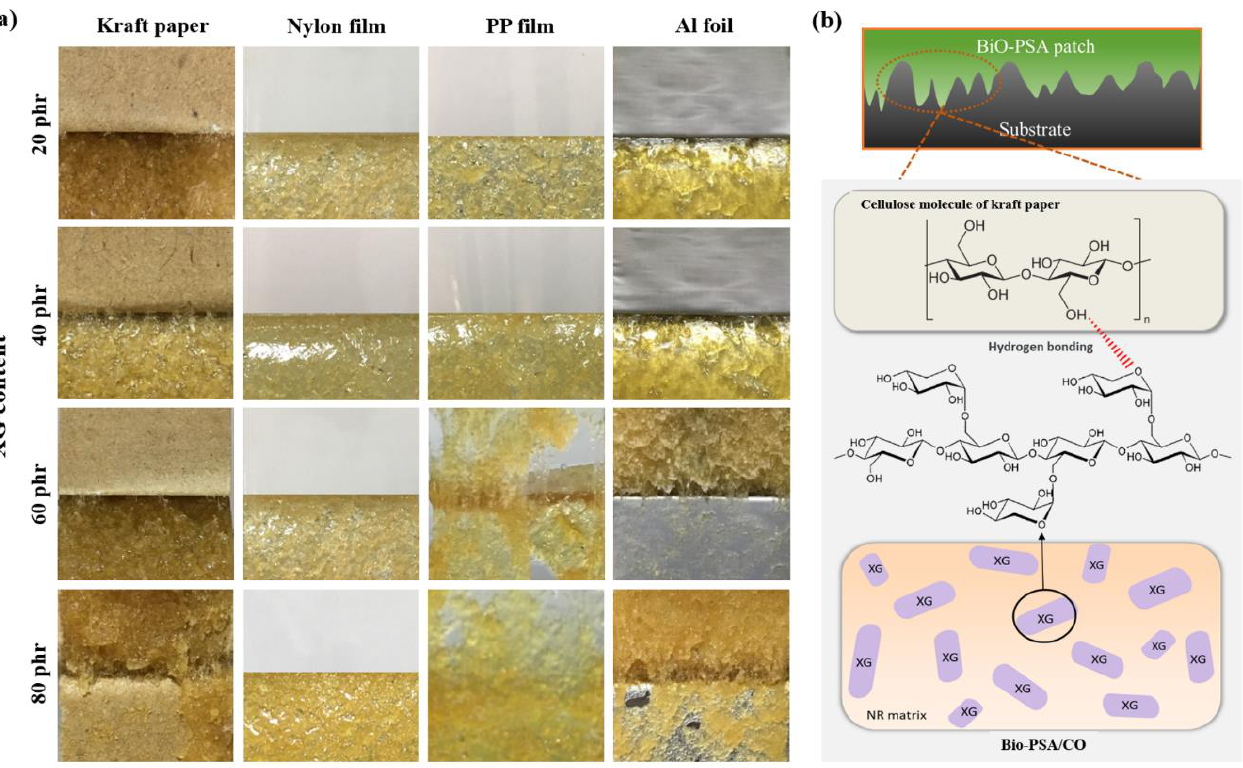
Figure 6. ( a ) Physical appearance of the NR-PSA/CO produced with 2 mm nip gap at a mastication time of 15 min with different XG content (20–80 phr); ( b ) proposed model of intermolecular interaction among cellulose molecules and XG of PSA.